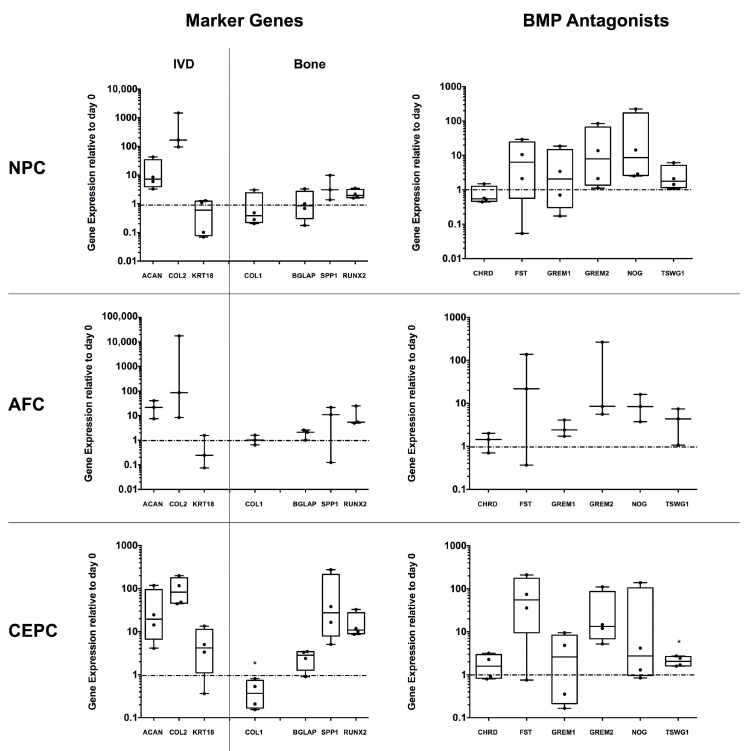
Figure 4. Expression of intervertebral disc and major bone marker and BMP antagonist genes in annulus fibrosus (AFC), nucleus pulposus (NPC) and cartilaginous endplate cells (CEPC) seeded in alginate beads and cultivated for 21 days in co-culture with human primary osteoblasts and stimulated with osteogenic medium. Data are presented as min to max with median and all data points. Gene expression was normalized to day 0 cells of the specific cell type. Significance was tested against day 0 cells. Students t -test, * p -value < 0.05, N =